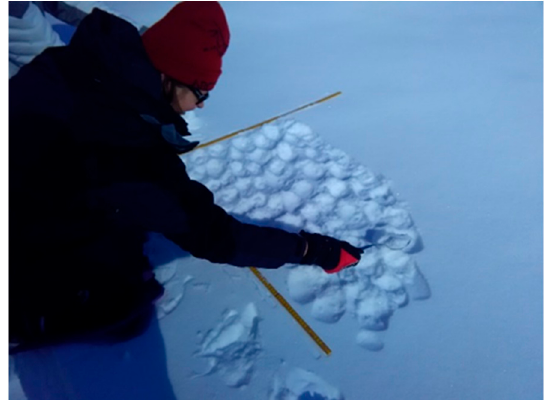
Figure 2. Snow sampling for the laboratory intercomparison at Kolm Saigurn, Austria.